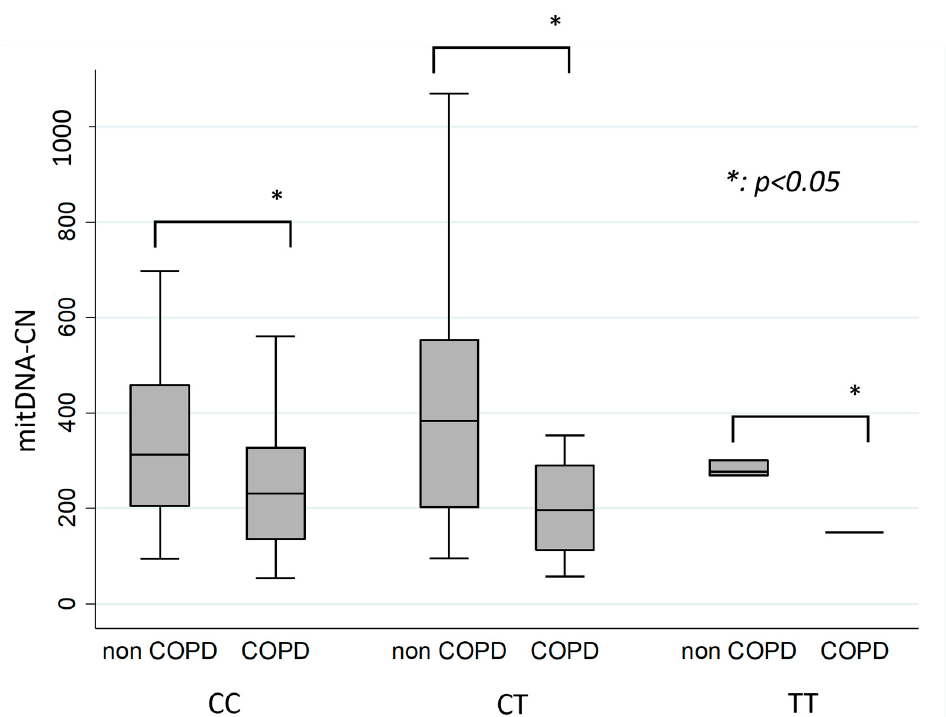
Figure 2. Comparison of mitDNA-CN in individual IL 13 genotype (CC, CT, TT) in COPD and non-COPD groups.